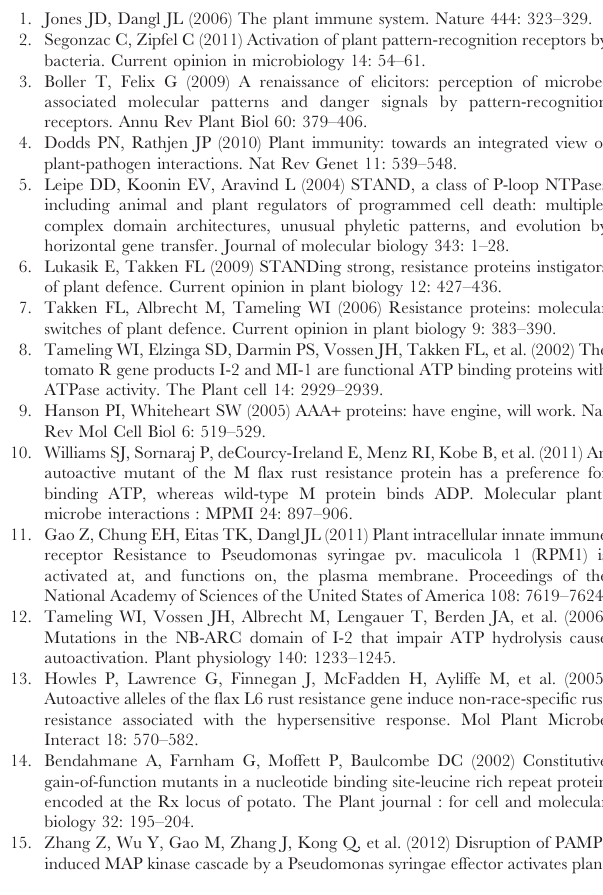
Figure S1 Quantification of plant growth based on fresh weight measurement. Five-week-old rosettes of the indicated genotypes were weighed. Means are representative of 10 plants for each genotype. Error bars indicate 6 2 6 SE. Figure S2 eds1 ADR1-L2 D484V plants segregating LSD1 show both wild-type and extreme cpr phenotypes. (A) Pictures of plants homozygous for eds1 and ADR1-L2 D484V and segregating lsd1 . (B) PCR genotyping of the indicated genotypes confirms that only LSD1 homozygous eds1 ADR1-L2 D484V ( # 5) plants have the severely stunted growth phenotype. # 1 and 2 indicate the Col-0 and lsd1-2 controls respectively, # 3–5 represent the genotypes from (A). Figure S3 RAR1 is not required for either steady state ADR1- L2 accumulation or BTH-mediated induction. (A) ADR1-L2-HA and rar1-21 ADR1-L2-HA plants were sprayed with 300 m M BTH. Plants were collected for protein extraction 24 hpi. Protein from Col-0, rar1-21 , and ADR1-L2-HA and rar1-21 ADR1-L2-HA plants + and -BTH were run on denaturing gels and probed with anti- HA antibody. (B) Protein from plants in (A) was also used in an anti-RAR1 Western blot to confirm the rar1-21 genotype. Ponceau stained blots in (A) and (B) show relative loading.